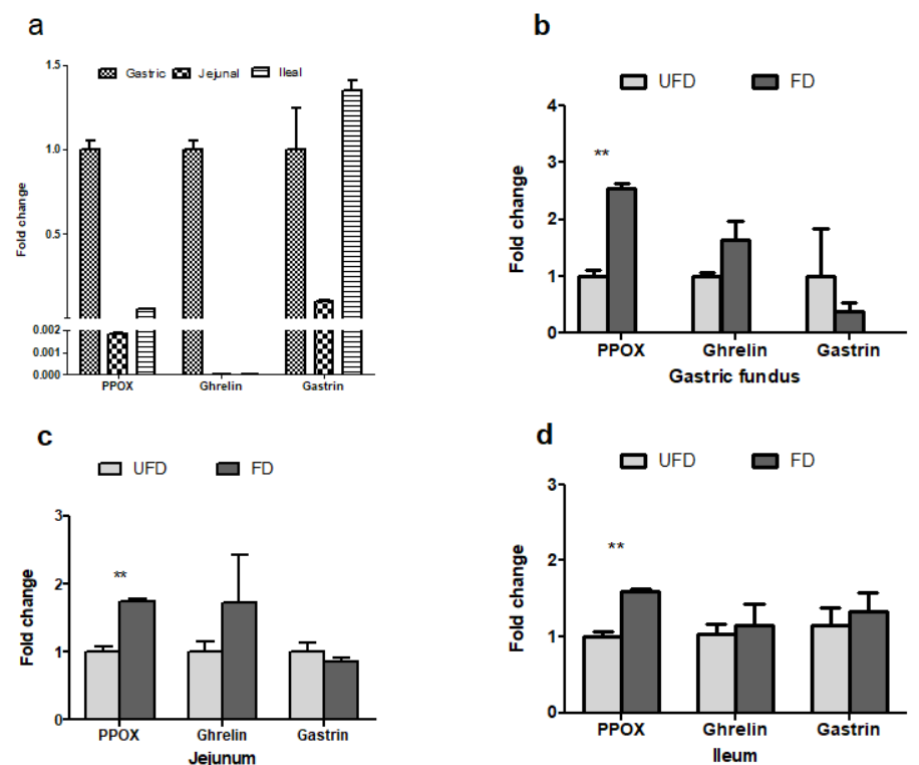
Figure 3. Relative gene expression of PPOX, ghrelin, and gastrin in porcine gastric fundus, jejunum, and ileum mucosa ( a ) and effects of fermented feedstuff (FFS) on the expression of the three genes in the gastric fundus ( b ), jejunum ( c ), and ileum ( d ) of weaned piglets. The mRNA expression was measured by real-time PCR with 5 mg of total mRNA. Glyceraldehyde 3-phosphate dehydrogenase (GAPDH) and tyrosine 3-monooxygenase/tryptophan 5-monooxygenase activation protein zeta polypeptide (YWHAZ) were used as reference genes, and the geometric mean of their Ct value was used as an internal control. The results of the feed change are shown as mean ± S.E.M. UFD: unfermented feed group; FD: fermented group. Bars with two stars denote a significant difference (p < 0.01).